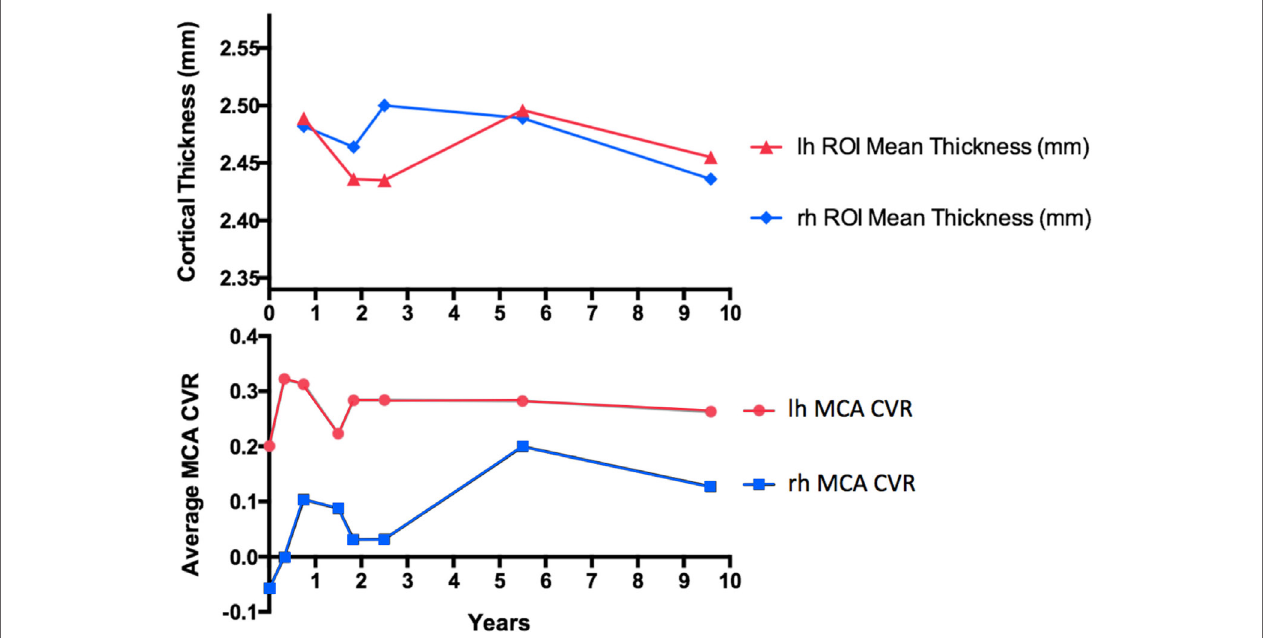
FIguRe 4 | Cortical thickness (CT) measurements compared with mean middle cerebral artery (MCA) territory cerebrovascular reactivity (CVR) change in a patient with large artery intracranial occlusive disease of the right MCA without surgical intervention, followed-up for over a 9-year interval. For CT measurements, only anatomical volumes with the same voxel size and imaging parameters were considered to remove unwanted biases in the longitudinal stream